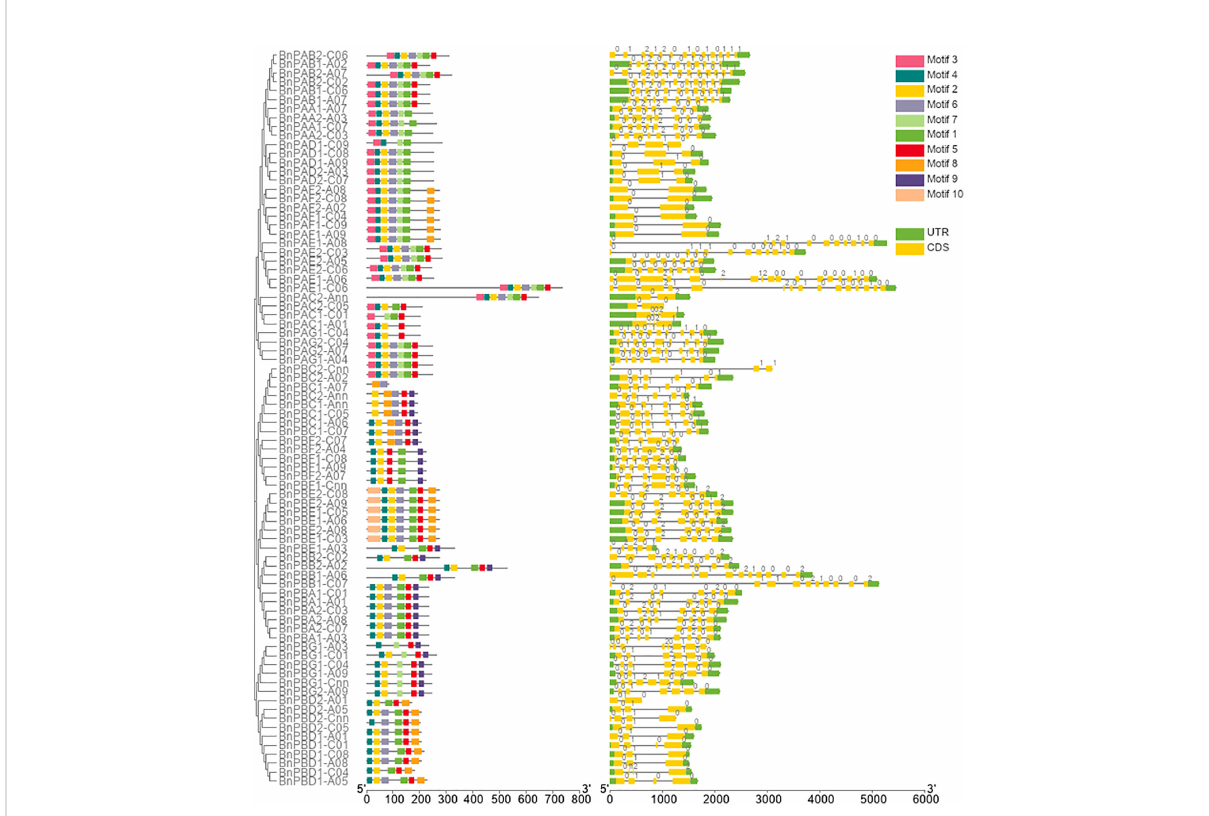
FIGURE 1 Structure of BnPA and BnPB genes of Brassica napus showing the distribution of exons (yellow solid bars), introns (black lines), upstream/ downstream regions (solid green bars), and intron phases marked as 0, 1 and 2. The fi gure also represents the conserved motifs identi fi ed in BnPA and BnPB